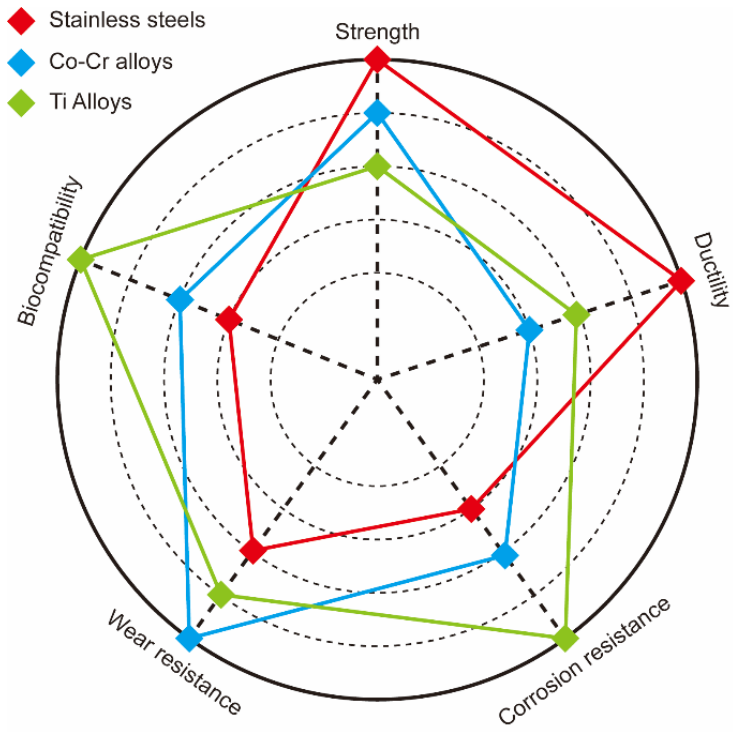
Figure 2. Comparison of strength, ductility, corrosion, and wear resistance as well as biocompatibility of stainless steel (red), Co–Cr (blue), and Ti (green) alloys.